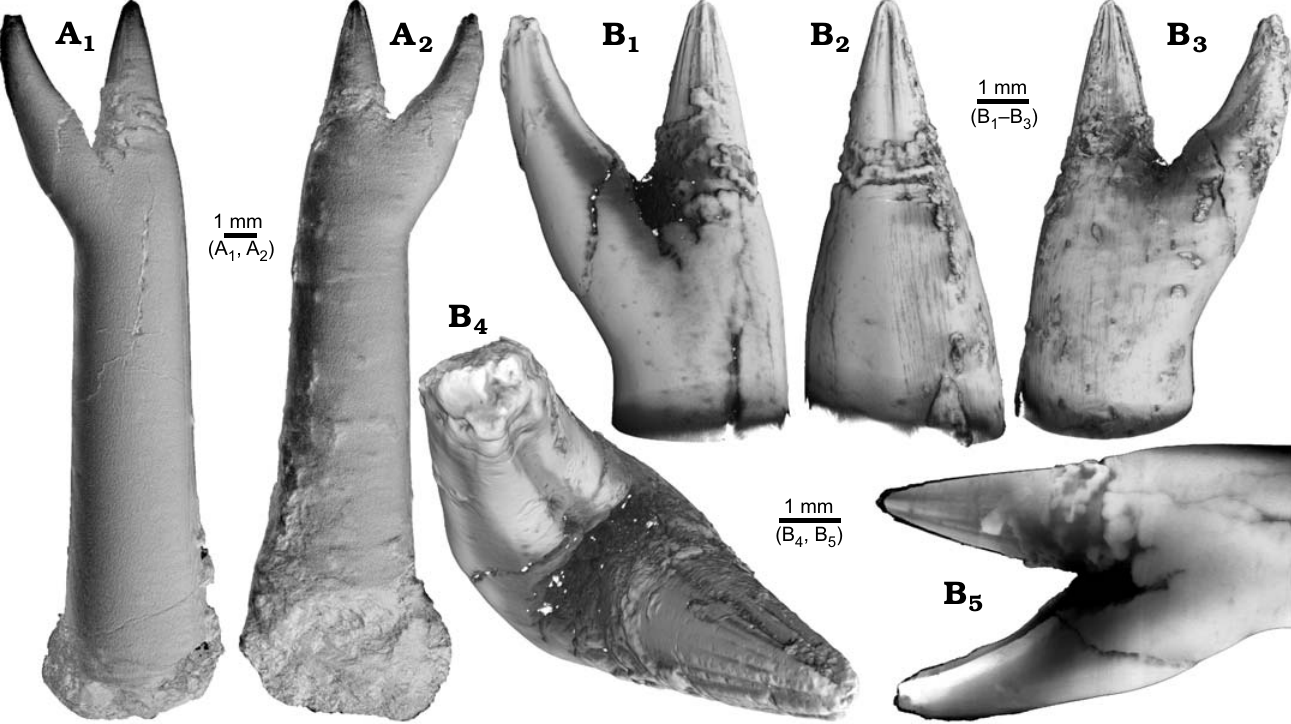
Fig. 1. Rostrum of belemnite ? Acrocoelites sp., PIMUZ 37346, Toarcian, Altdorf (SW-Germany) with forma aegra saepia (leg. M. Weissmüller). A . Overview